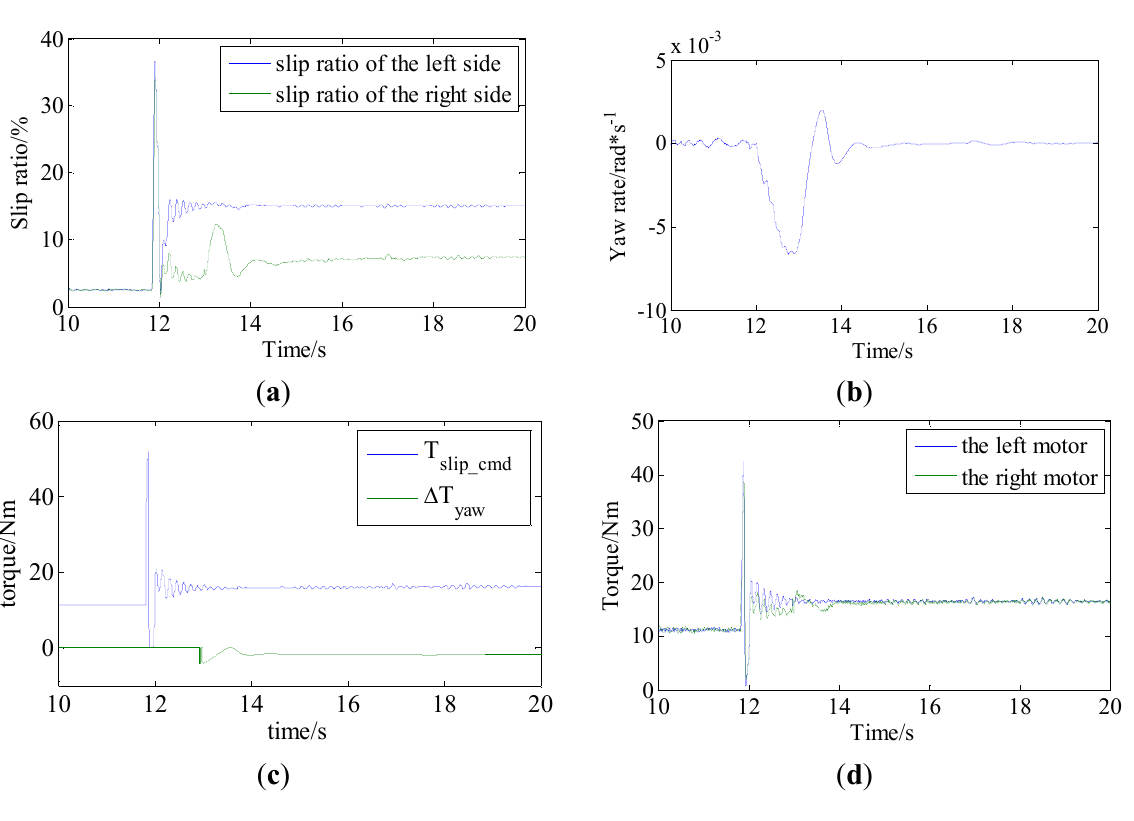
Figure 16. Experiment results of acceleration slip regulation on a low friction coefficient road: ( a ) slip ratios of driving wheels; ( b ) yaw rate of vehicle; ( c ) torque commands of slip ratio control and yaw rate control; and ( d ) motor torque